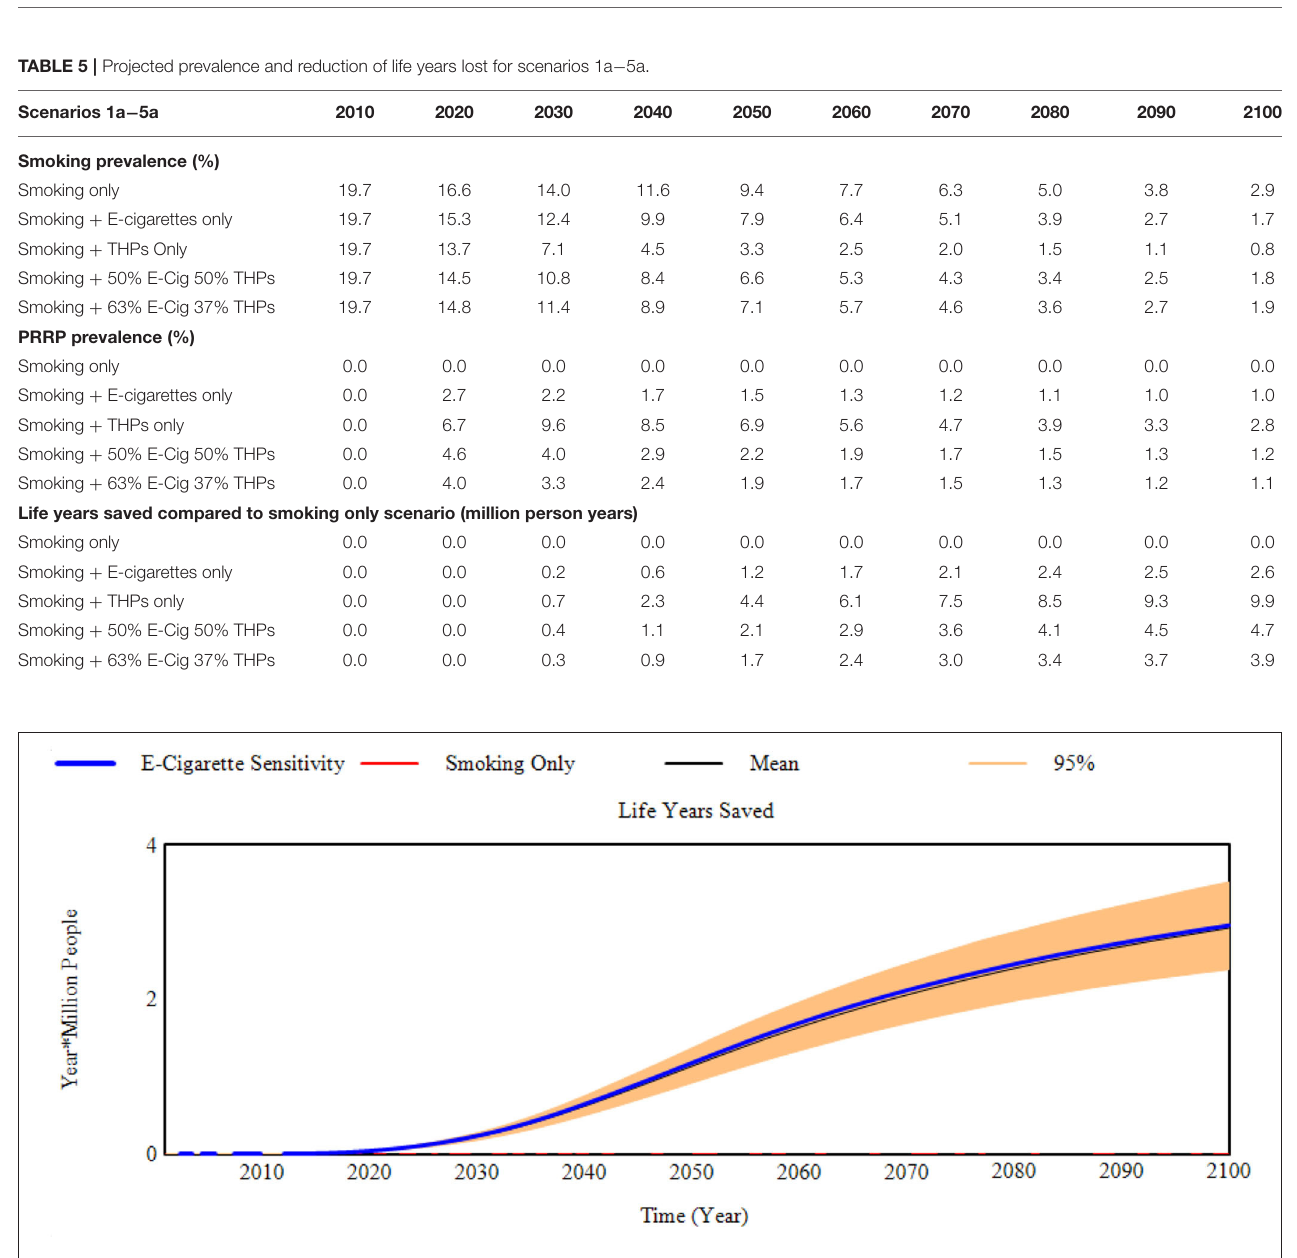
FIGURE 3 | Reduction in life years lost compared to the smoking only scenario (Life years saved) for the E-Cigarette scenario sensitivity to transition